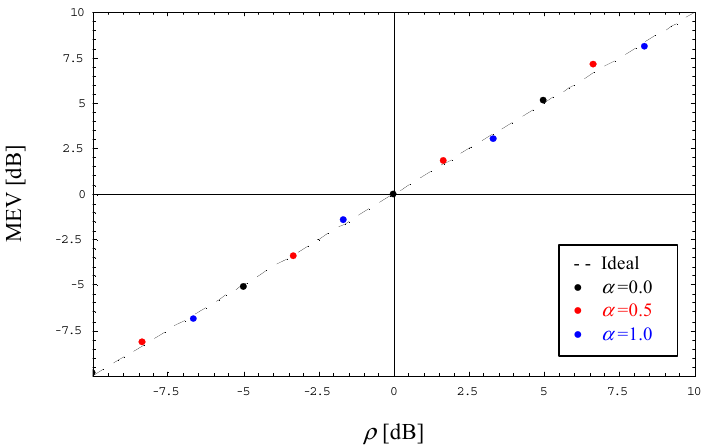
Figure 4. Mean estimator value for amplitude recovery using SDJ shapes (flat filter (FF) receiver).